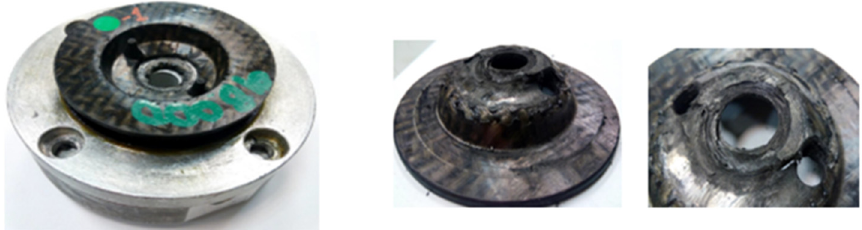
Figure 12. PA6-FG sheet: 3 mm CFRTP deformed after the fatigue test.